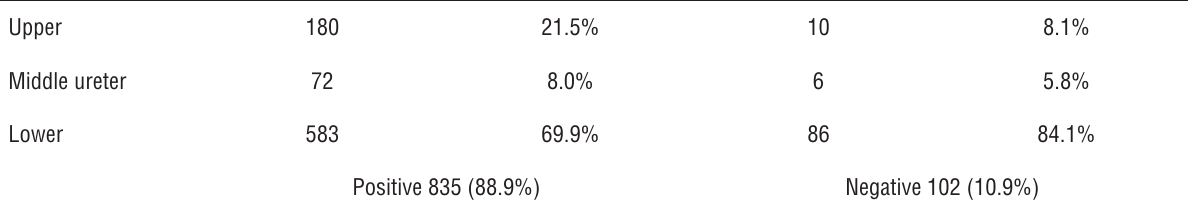
Table 3 - Relation between microhematuria and stone site in Color Doppler examined cases.